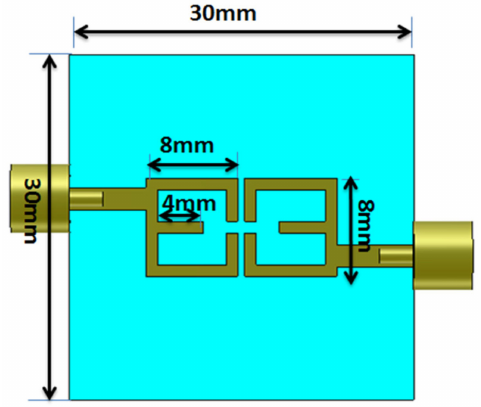
Figure 9. 2-D configuration of stub-loaded OLR BPF with 0 ◦ feed structure.